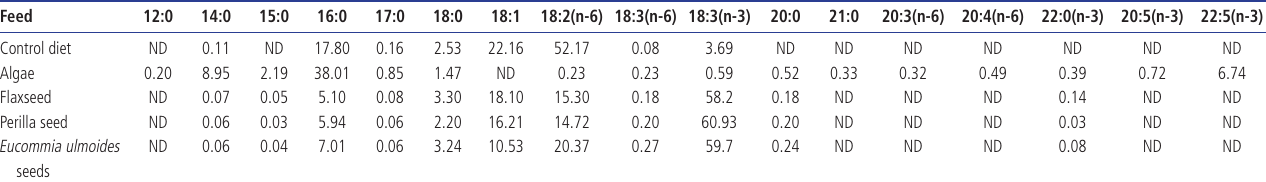
Table 2. Composition of fatty acids (expressed as % of the total fatty acids) of fodder components applied in feeding of